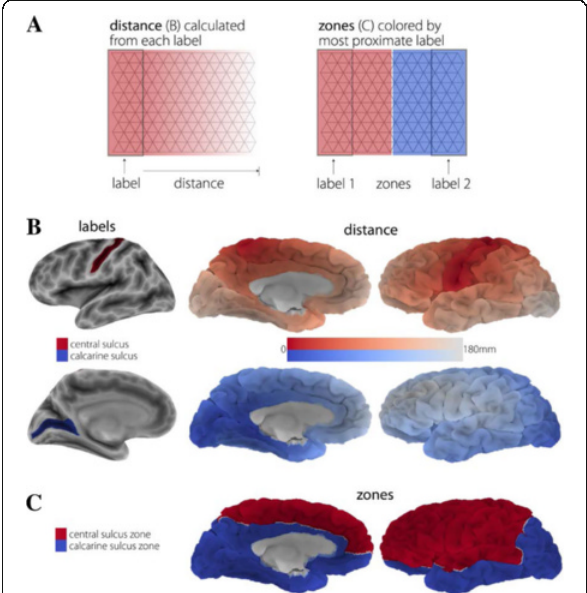
Fig. 14 (abstract A17). a Schematic illustrating the distance ( b ) and zone ( c ) analyses. b FreeSurfer labels from the central and calcarine sulci depicted on the individual inflated surface (left), and the exact geodesic distance from the two labels presented on an individual pial surface (right). c Zones delineated based on proximity to the central (red) or calcarine (blue)